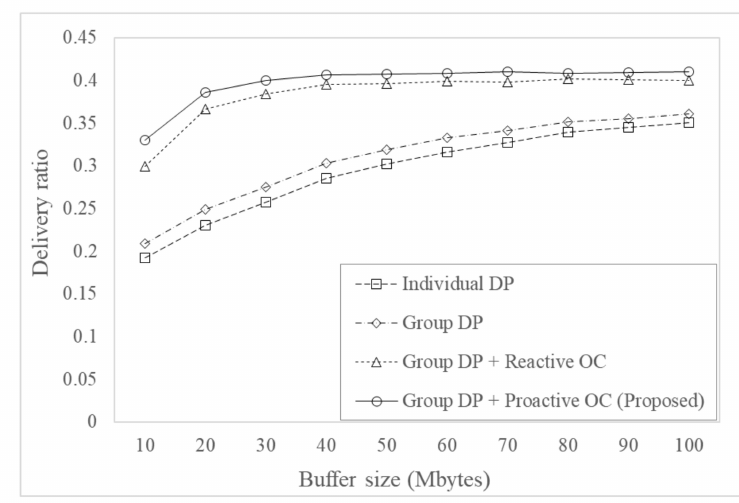
Figure 5. Delivery ratio for varying buffer size.